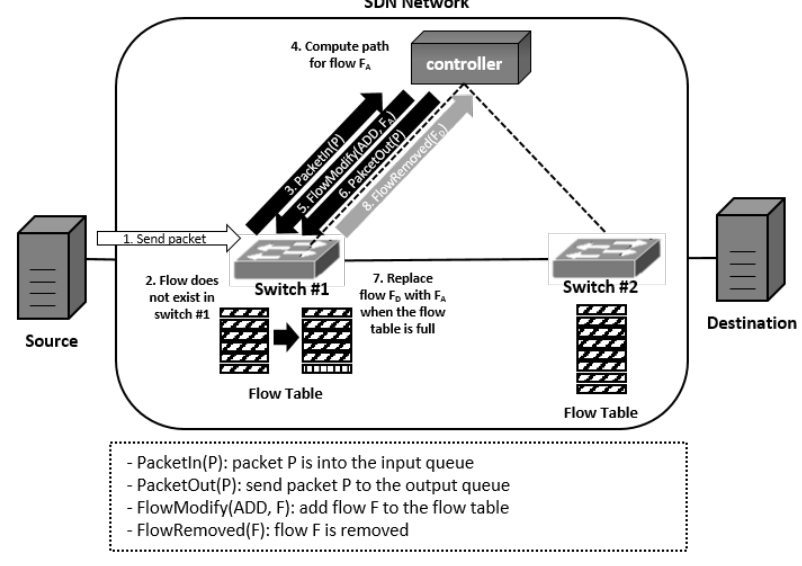
Figure 1. The Software Defined Network (SDN) comprising switches with different sizes of the flow tables.